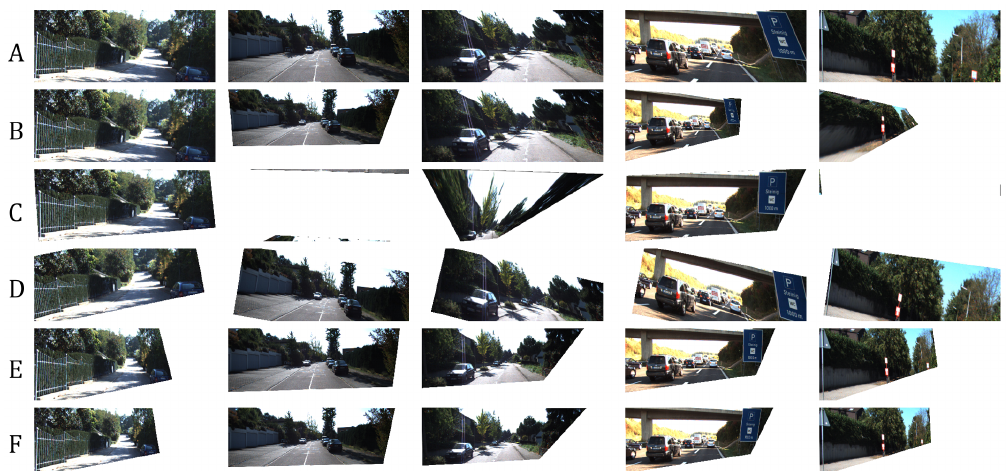
Figure 7. Results using unseen data from KITTI. ( A ): Distorted input images. ( B ): Corrected image using homography estimation ( C ): Corrected image using the technique of Chaudhury et al. [21]. ( D ): Corrected image using the technique of Li et al. [11]. ( E ): Corrected image using our method. ( F ): Ground-truth. Visually comparing the images, our network learned how to correct an image close to the ground-truth compared to other works.